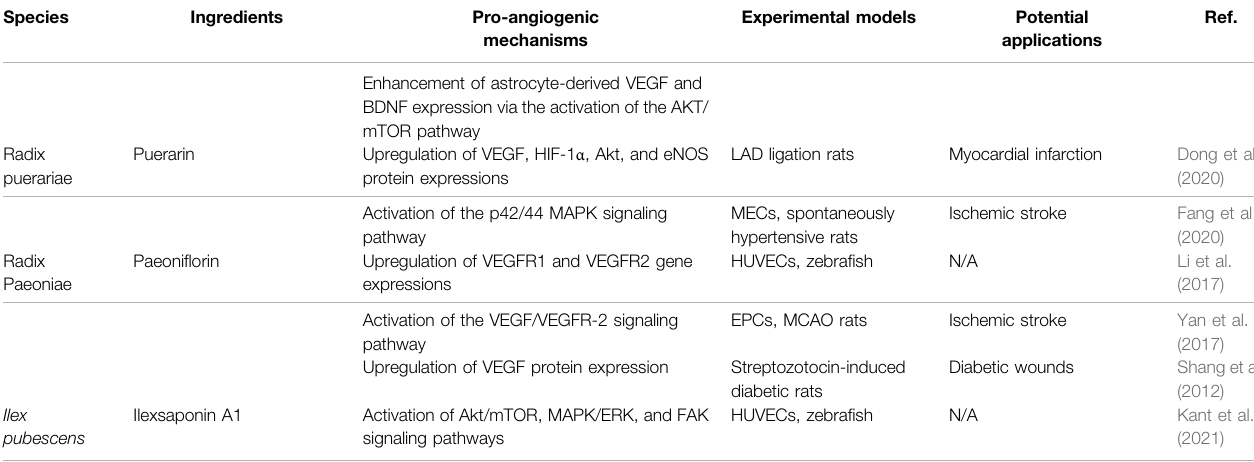
TABLE 3 | ( Continued ) Summary of pro-angiogenic phytochemicals and their potential